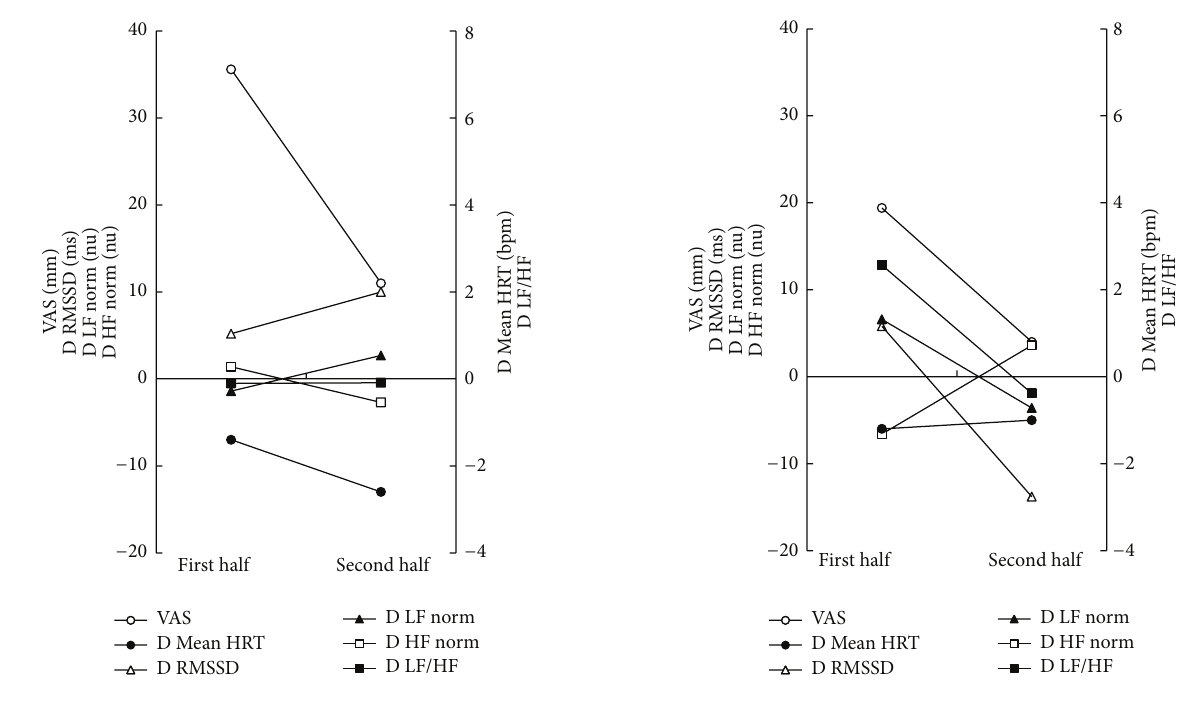
Figure 3: Time course of differential frequency-/time-domain parameters during SGR in case 3.